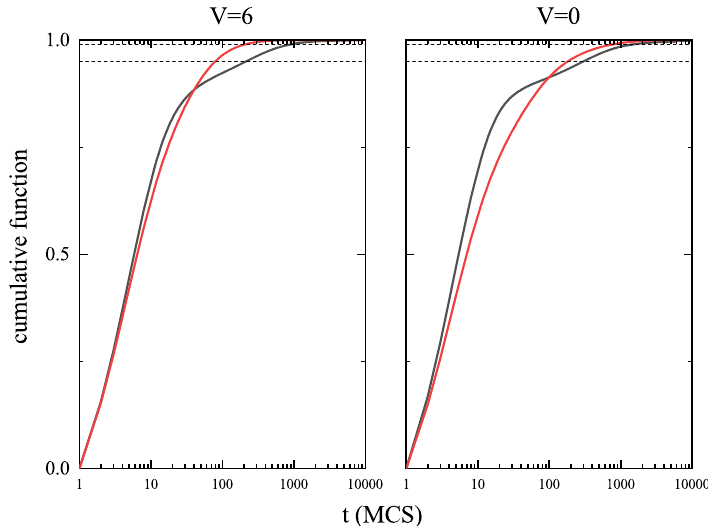
Figure 5. Empirical cumulative functions F ( V , t ) for V = 6 ( left ) and V = 0 ( right ). T = 0.25 (blue line) and T = 0.5 (red line). Horizontal lines mark the values 0.95 and 0.99.